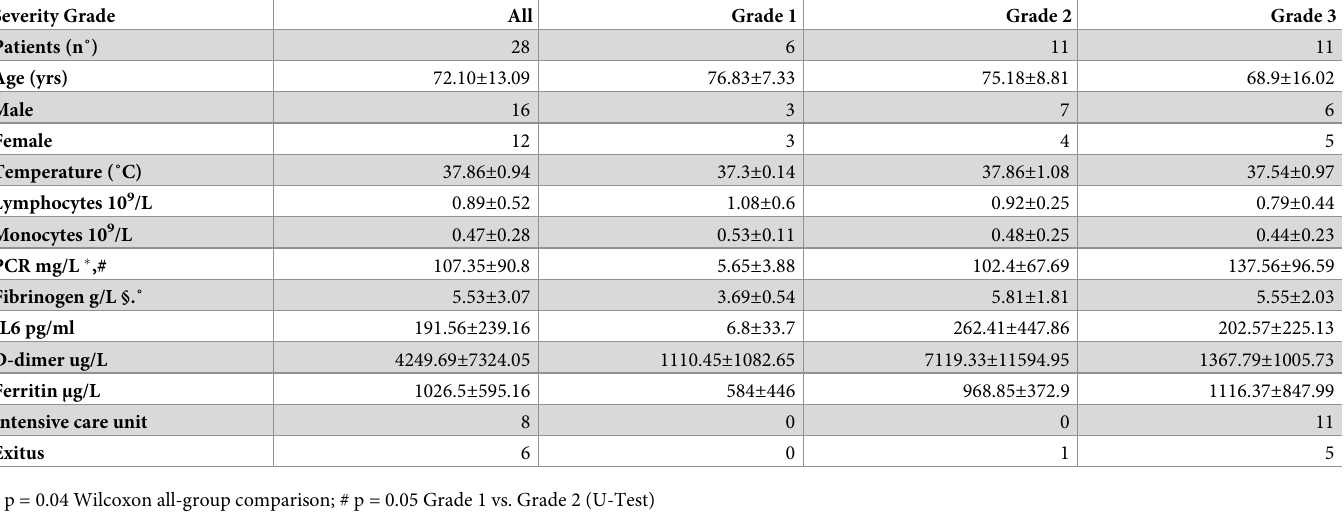
Table 1. Demographic, laboratory and severity characteristics of the study cohort. Severity Grade All Grade 1 Grade 2 Grade